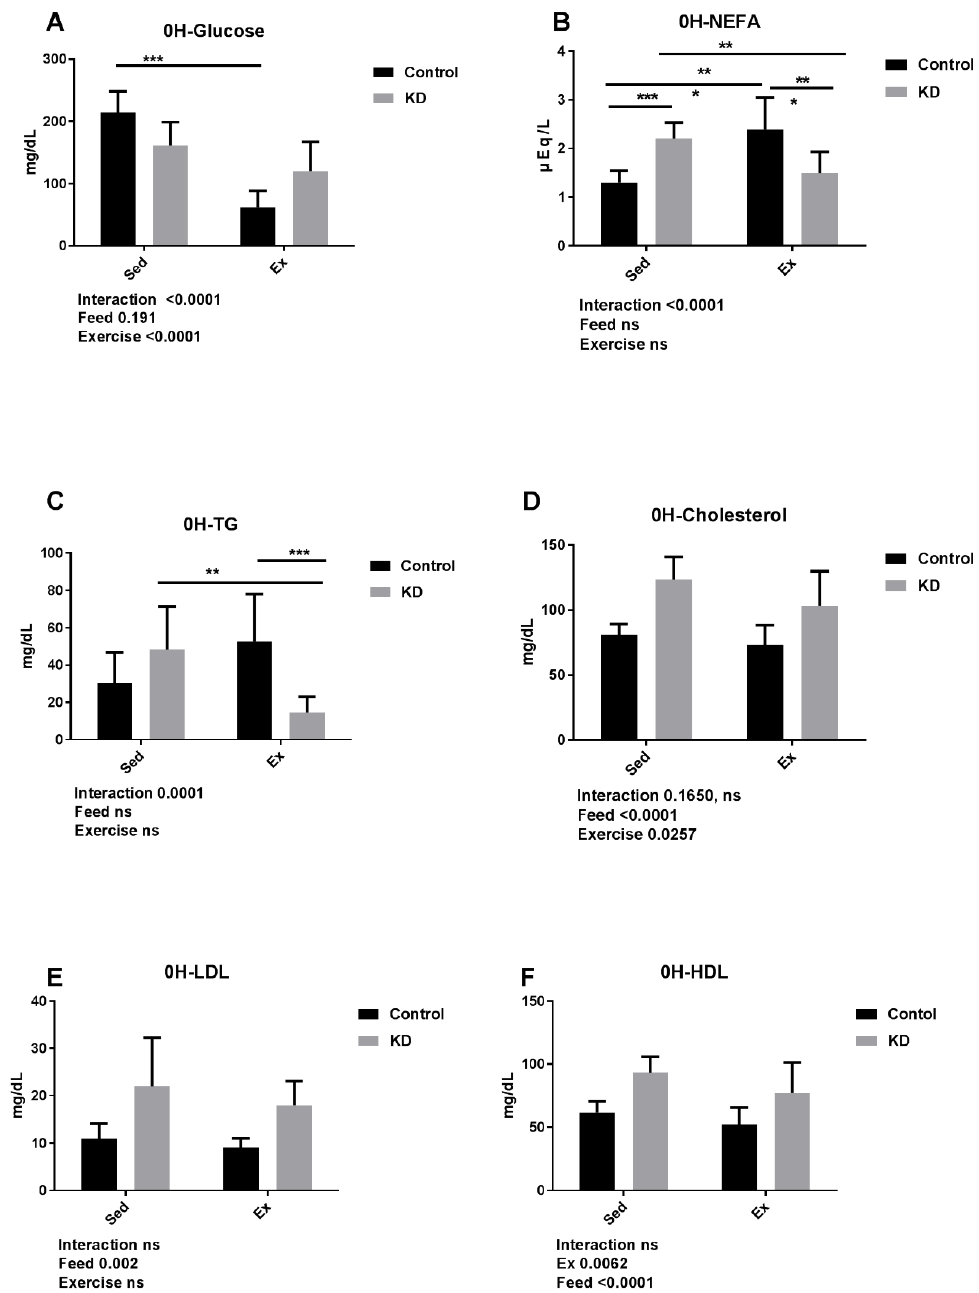
Figure 3. Plasma biochemistry results after KD feeding and immediately after exhaustion as indicated. A-F: Concentration of plasma glucose, non-esterified fatty acids (NEFA), triglyceride (TG), lipase, cholesterol (CHO), high-density lipoprotein cholesterol (HDL) and low-density lipoprotein cholesterol (LDL). * p < 0.05, ** p < 0.01 and *** p < 0.001. 3.5. Effects of KD on Plasma Albumin, AST, ALT, Lipase, Amylase, CK, LDH, UA and BUN Immediately after Endurance Exercise